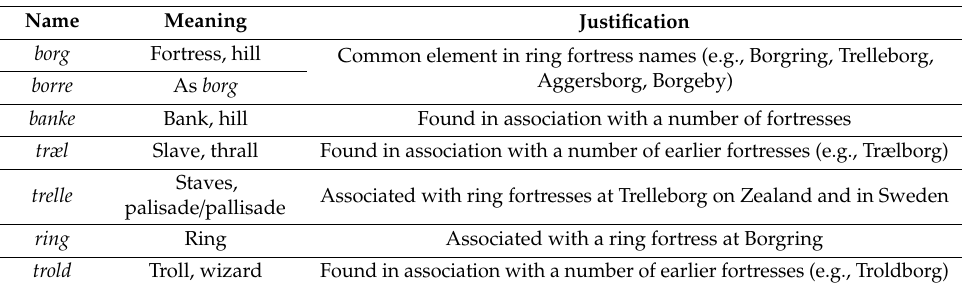
Table 3. Place names that possible are correlated to fortress locations used as proximity rasters to explore correlation between these names and possible fortress